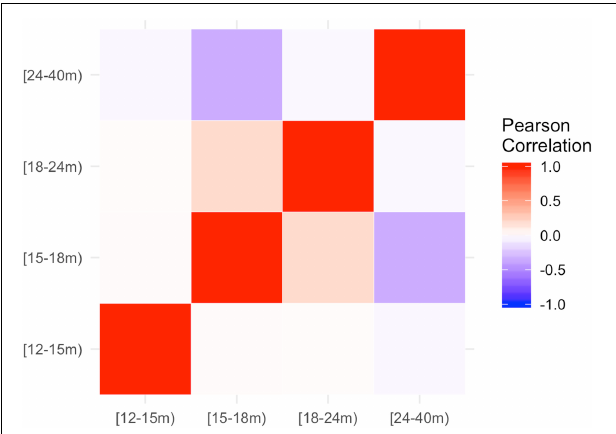
FIGURE 4 | Visualization of the Pearson Correlation between the fishing efforts observed for the different length classes, as estimated by the VMS data. Correlation values are represented with a color scale ranging from blue (negative) to red (positive) values. The fleet segments are named according to the ranges of length-over-all of the vessels. The notation [ x , y ) is used to indicate an interval from x to y that is inclusive of x but exclusive of y